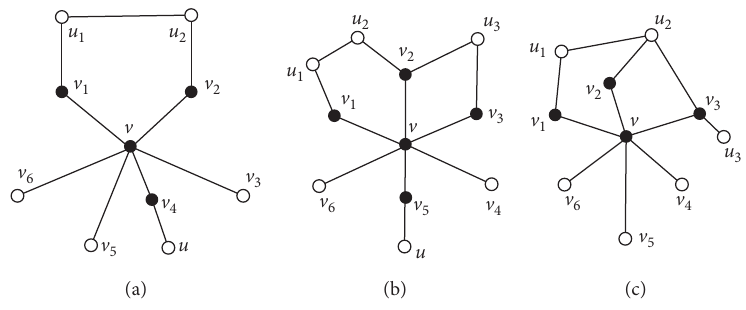
Figure 2: Three forbidden configurations in H